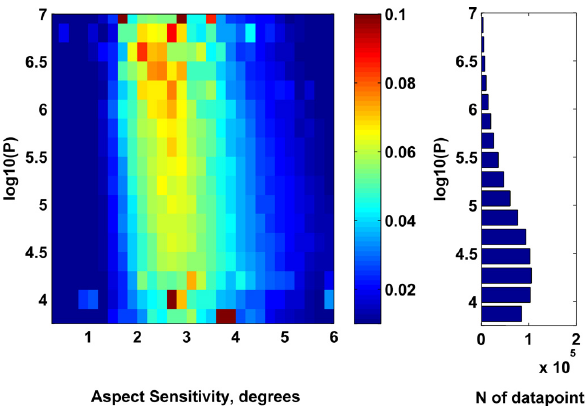
Fig. 7. Left panel: distribution of PMSE aspect sensitivity parame- ter for each interval of echo power averaged over all 11 years. Each row is normalized so that the sum of all data bins in it is 1. Right panel: number N of data points contributing to each